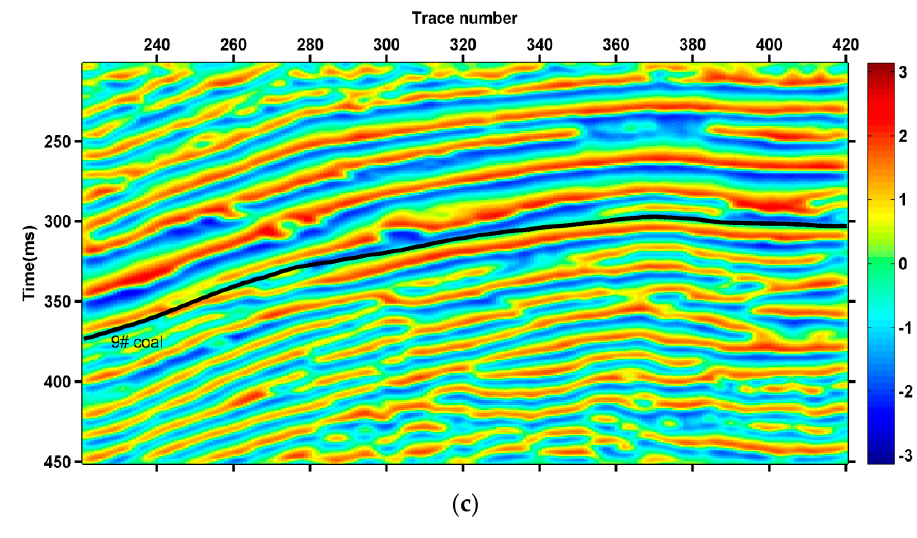
Figure 12. The instantaneous attributes of IMF2. ( a ) the instantaneous amplitude of IMF2; ( b ) the instantaneous frequency of IMF2; ( c ) the instantaneous phase of IMF2.